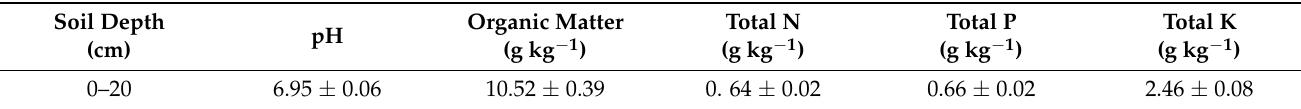
Table 1. Physical and chemical properties of initial soil of the experimental